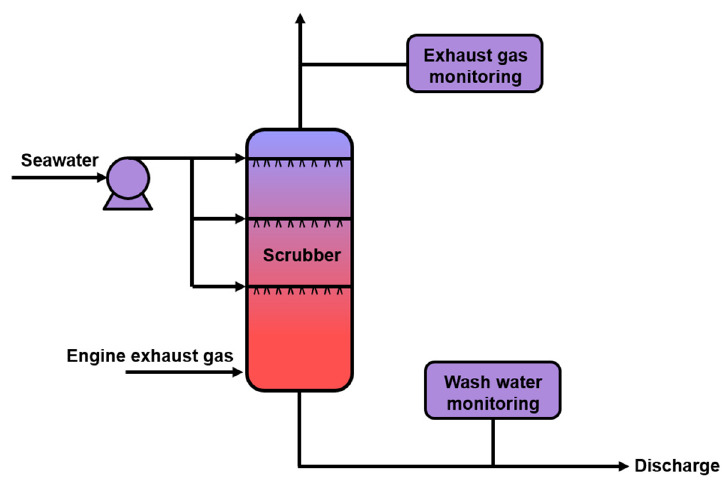
Figure 5. Schematic diagram of a multiple scrubber feed.